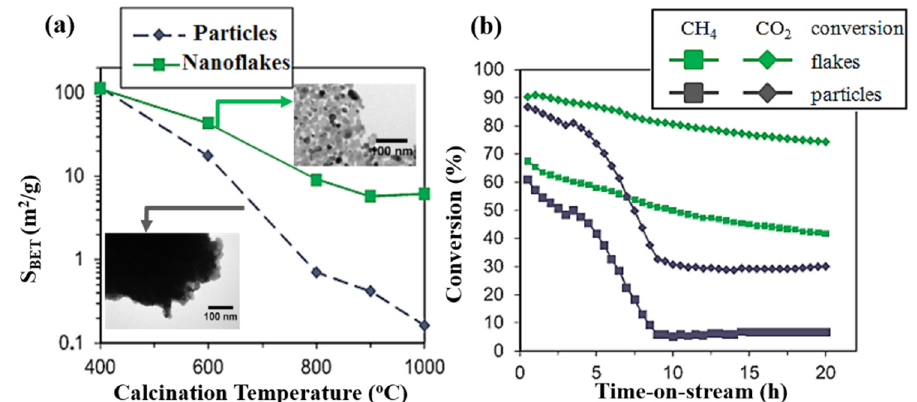
Figure 4. ( a ) S BET vs. calcination temperature for GO-templated ceria flakes and non-templated ceria particles; ( b ) long-term catalytic activity of Ni-loaded ceria flakes and particles at 800 °C in the dry reforming of methane, both CH 4 and CO 2 conversions are shown (adapted from [45]).